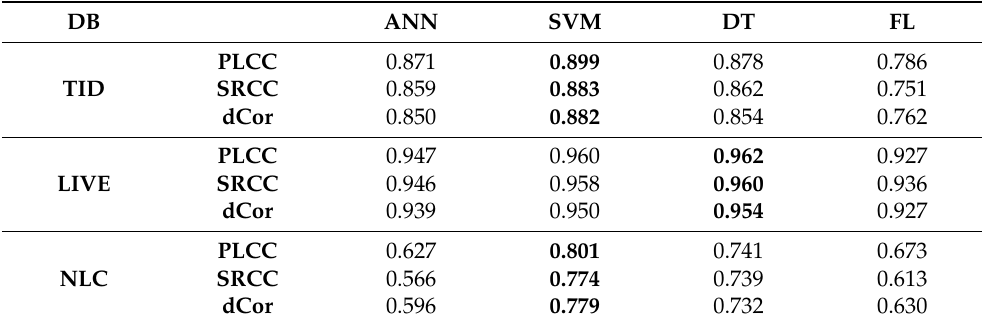
Table 4. Correlation score of MOS vs. estimated image quality of different image databases using different ML methods for